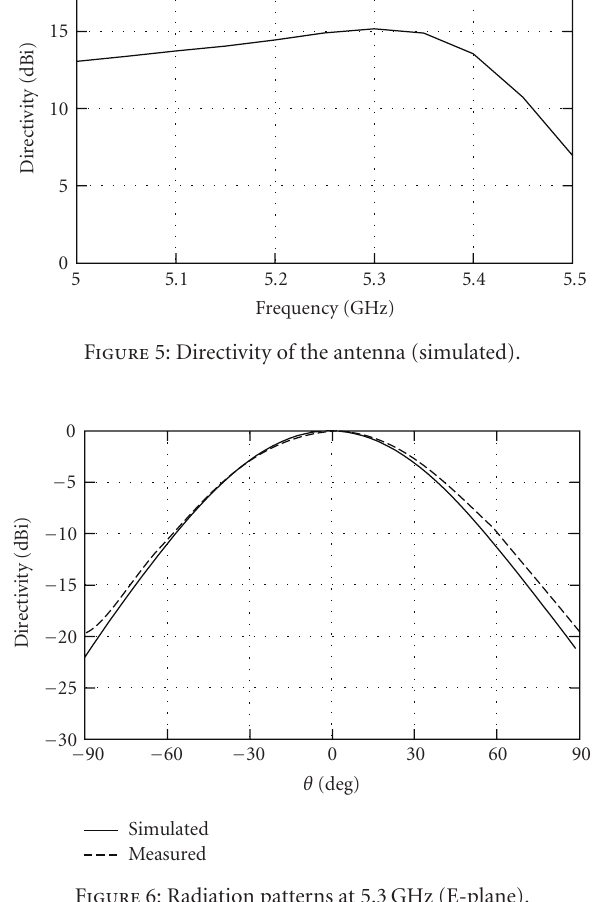
Figure 8: Front, top, and 3D views of the sectoral EBG antenna, monosource case: only the patch in the center is fed, multisource case: three patches are fed